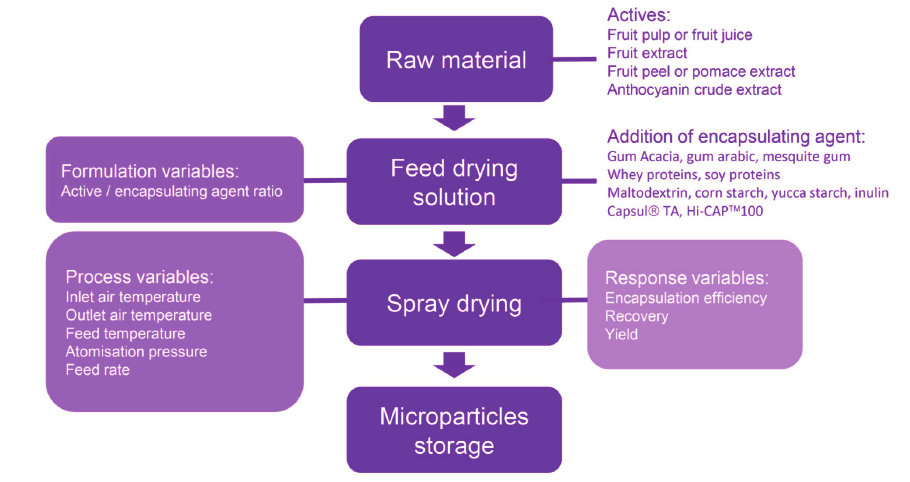
Figure 1. Microencapsulation of anthocyanins from berry-type fruits by spray drying and variables that must be considered in the feed formulation and